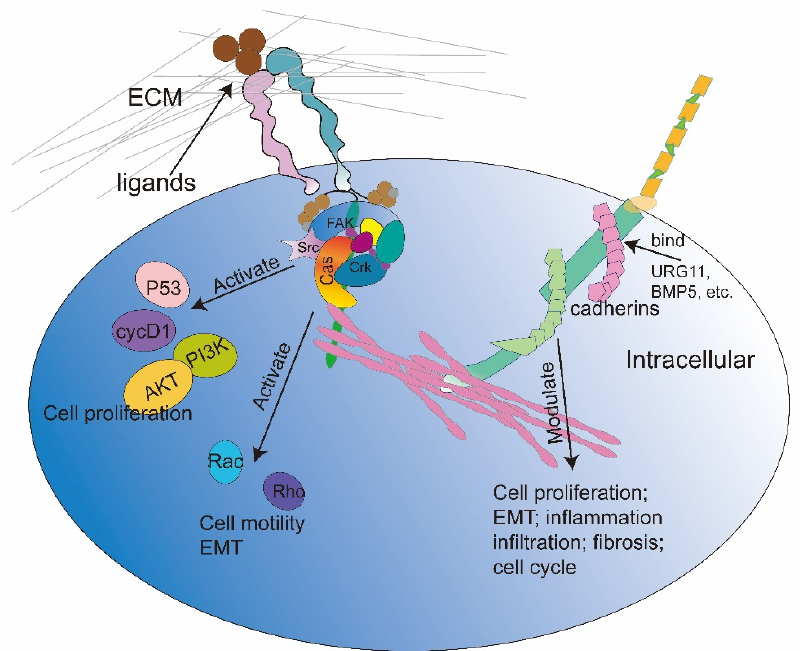
Figure 3. CAMs on prostate cells: ECM or ligands combine with integrin to recruit talin, paxillin, FAK, Src, and other proteins to form a complex. The integrin complex further regulates cell proliferation and apoptosis by regulating downstream PI3K-AKT signal, cycD1 activation, and P53 expression. In addition, the complex could directly affect the activity of Rho and Rac to regulate cell migration and EMT. Some molecules such as URG11 and BMP5 bind to E-cadherin and/or N-cadherin in prostate cells. After binding those molecules, cadherins can directly regulate cell proliferation, EMT, inflammation, fibrosis, and the cell cycle.